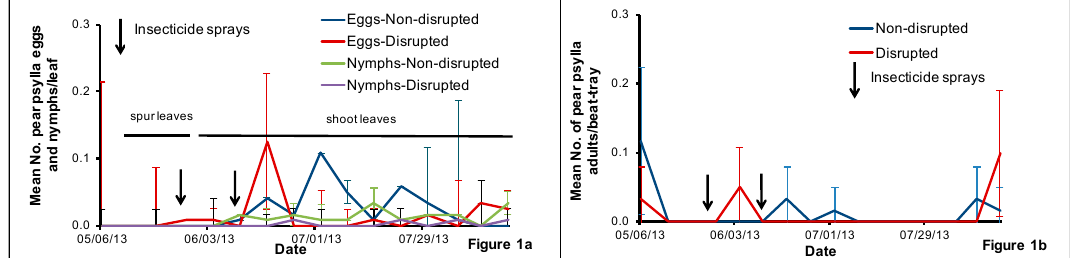
Figure 1. Mean number (±SE) of pear psylla eggs and nymphs per spur or shoot leaf ( a ) and pear psylla adults per beat-tray ( b ) for the samples collected in the natural enemy non-disrupted and disrupted plots in a pear orchard in White Salmon, Washington, USA, from May to August 2013. Significant differences between the treatments when present are noted on the graph using an asterisk (* = significance at p ≤ 0.05).